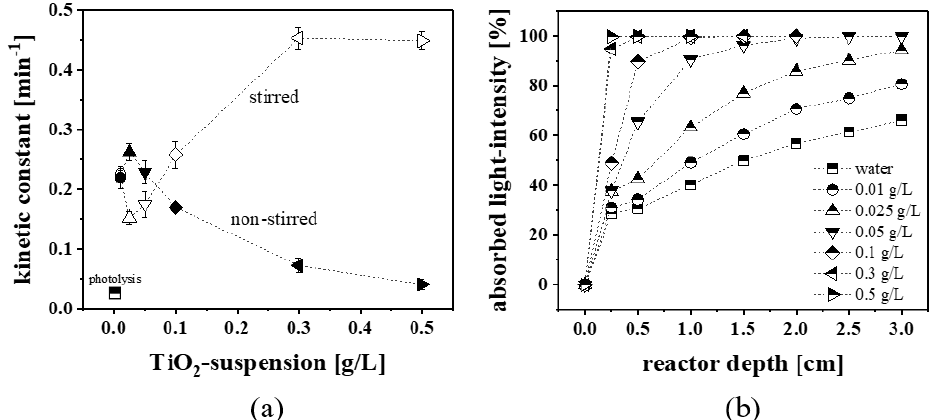
Figure 4. Photon − induced degradation of bisphenol A and irradiation characteristics. ( a ) photolytic and photocatalytic degradation rates for TiO 2 dosages of m cat. = 0–0.5 g/L and λ = 300 nm. ( b ) absorbed light intensity for TiO 2 dosages of m cat. = 0–0.5 g/L and λ = 300 nm depending on the reactor depth.